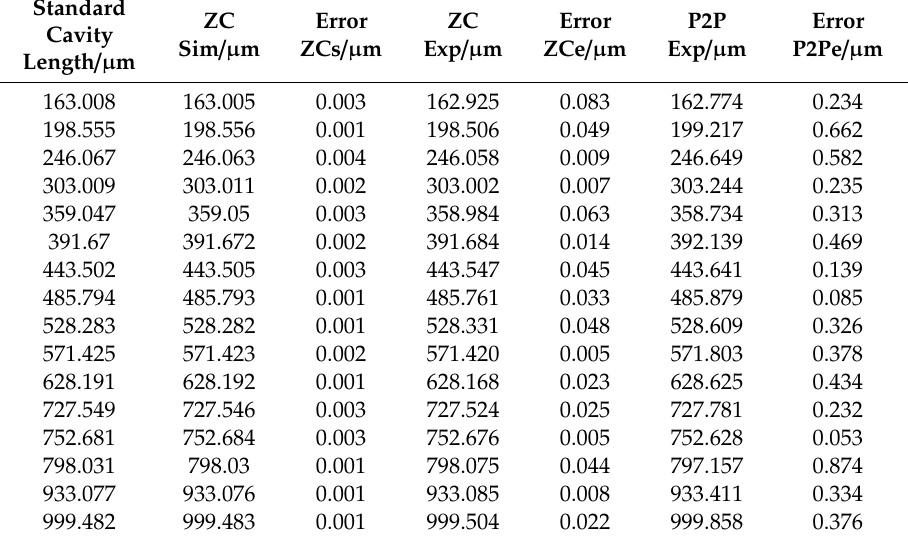
Table 1. Interrogation results and errors for fiber-optic FP sensors with di ff erent cavity lengths. Both results obtained by the zero-cross detection algorithm and the peak-to-peak method are given for comparison. The column ZC Sim gives the cavity lengths given by zero-cross simulation; ZC Exp and P2P Exp, respectively, give the cavity lengths acquired from the experimental spectra; the columns Error ZCs, Error ZCe, and Error P2Pe are the corresponding cavity lengths interrogating the